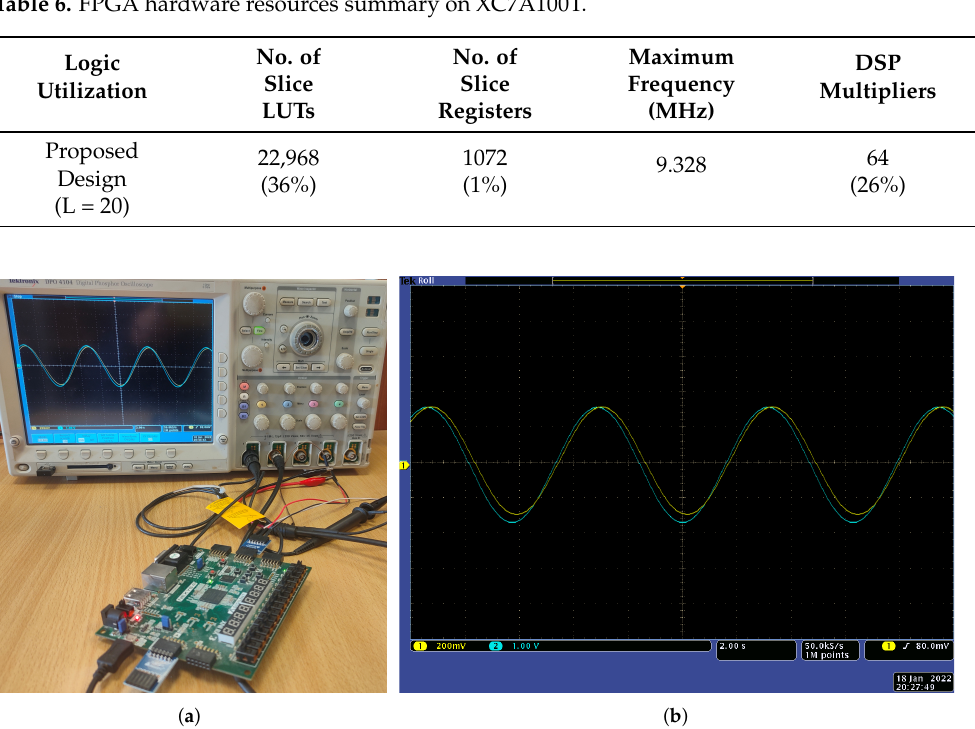
Figure 4. Oscilloscope FPGA results of integration process at q = − 0.9 and L = 20 for a sine signal as input; ( a ) FPGA testing environment, ( b ) proposed approach